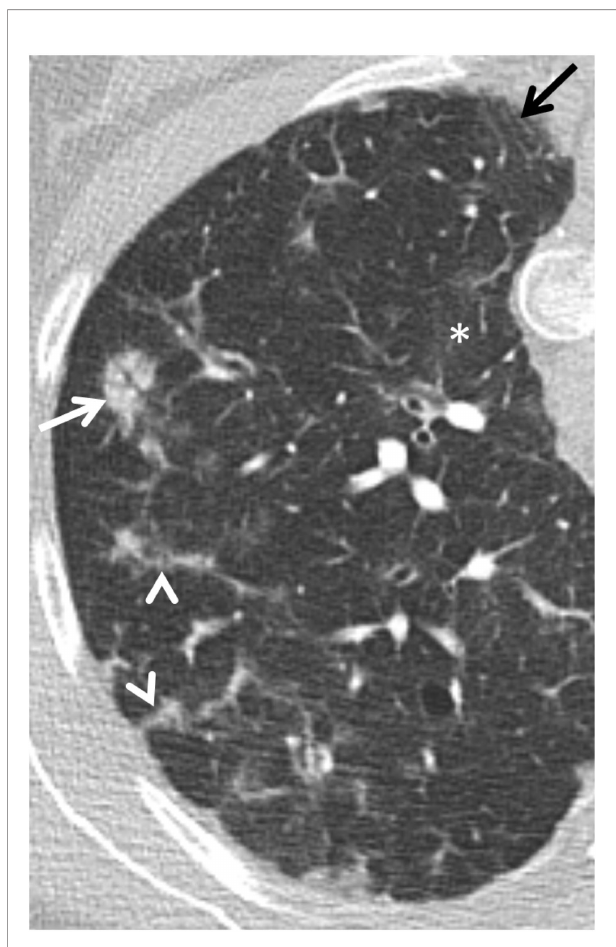
FIGURE 1 | HRCT image of the right upper lobe of a 40-year-old woman with characteristic fi ndings of granulomatous-lymphocytic interstitial lung disease (GLILD) with irregular peribronchovascular interstitial thickening (white arrow), interlobular septal thickening (arrowheads), subtle ground glass opacities (asterix), and traction bronchiectasis (black